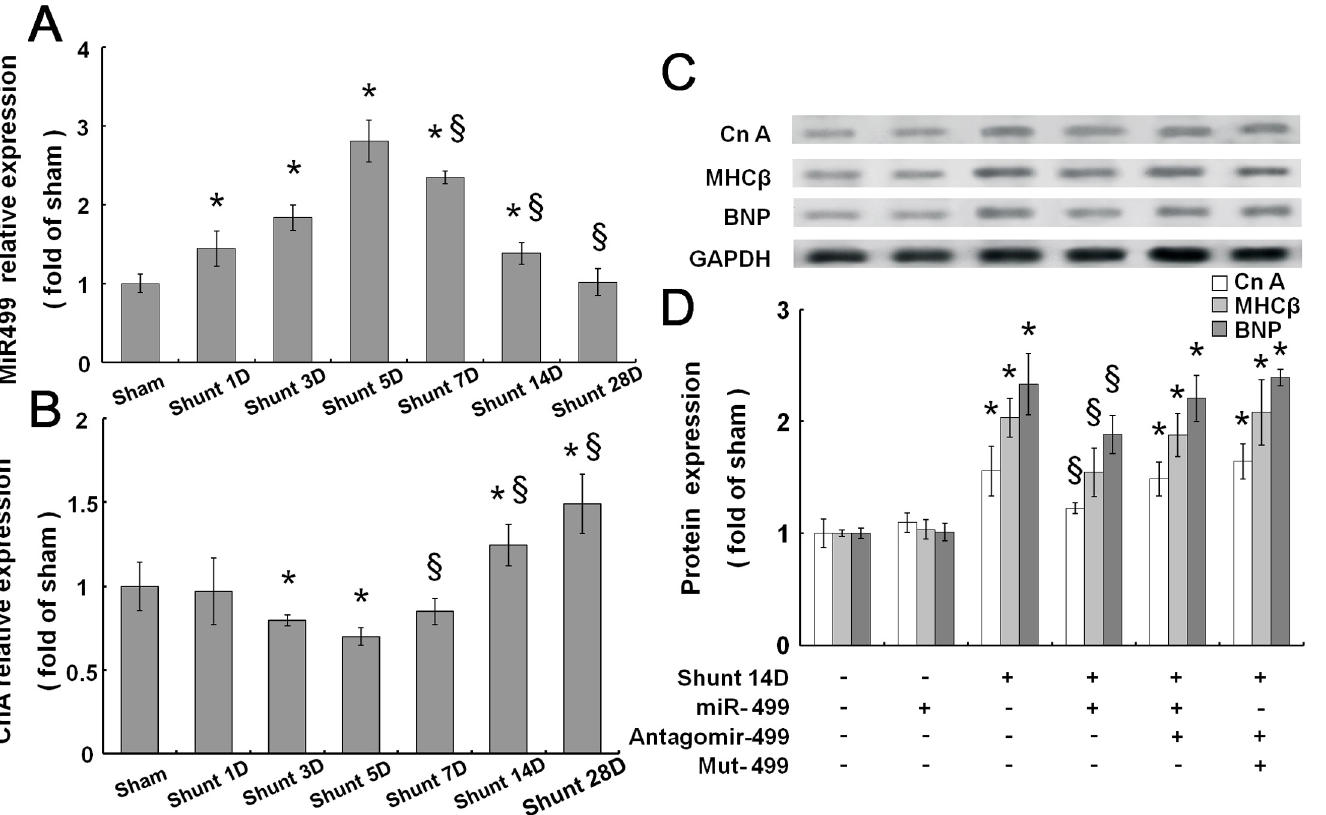
Fig 5. Representative expression of miR499 (A) and CnA protein (B) of left ventricular myocardium in aorta-caval (AV) shunt rats for 1 to 28 days. (C) Western blot for CnA, MHC-ß, and BNP protein expression from left ventricular myocardium after 14 days of shunting with miR499, mutant miR499, and antagomir499 overexpression,. (D) Quantitative analysis of CnA, MHC-ß, and BNP protein levels of the left ventricular myocardium in AV shunt rats. * p < 0.001 vs.